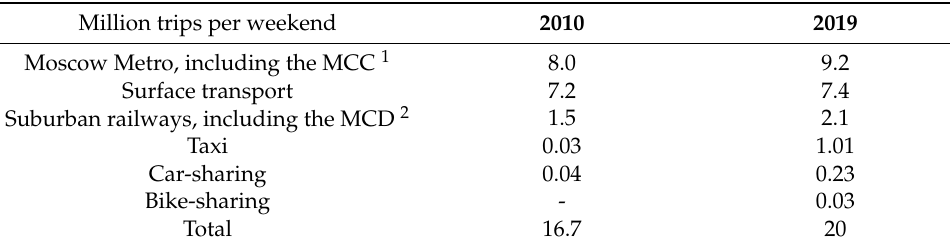
Table 1. Daily passenger traffic in Moscow in 2019